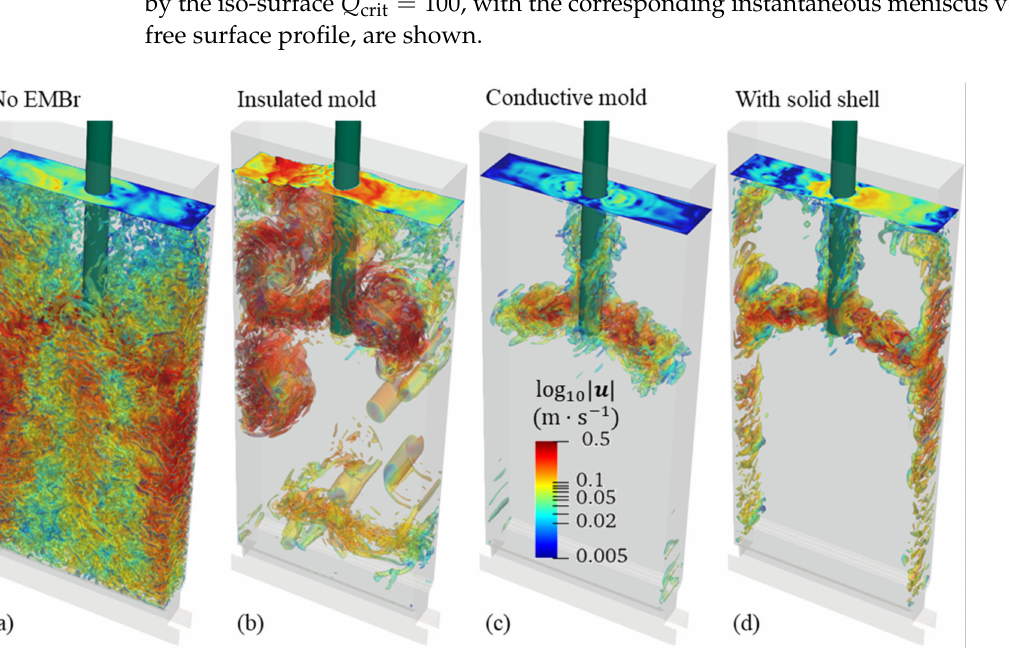
Figure 13. Turbulent flow structures ( Q crit = 100), SEN immersion depth of 100 mm: ( a ) Case 0A; ( b ) Case 1A; ( c ) Case 2A; ( d ) Case 3A.